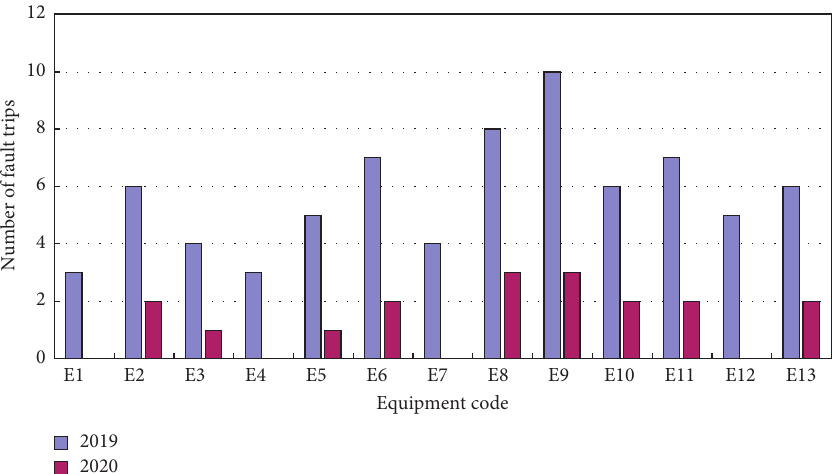
Figure 7: Comparison results of fault trip times before and after use of monitoring system.